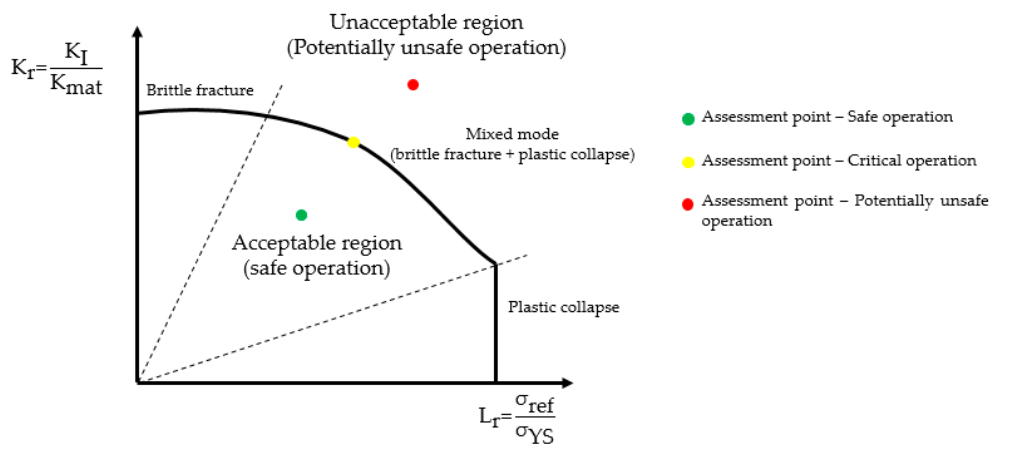
Figure 19. Schematic on the usage of failure assessment diagram (FAD) for structural integrity assessment.